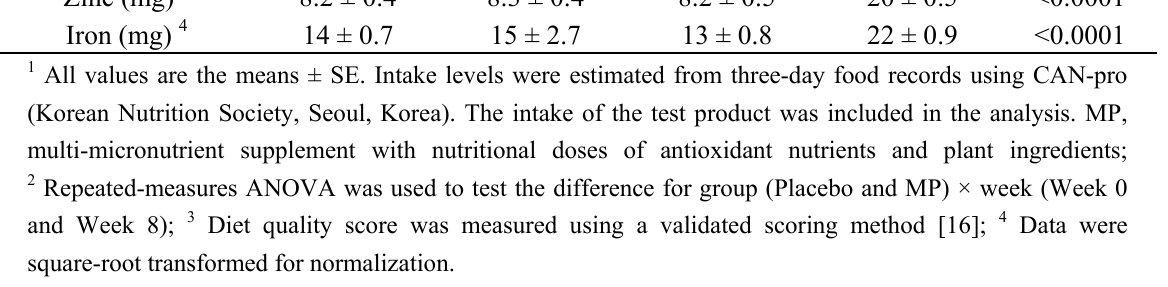
Figure 2. Relationship between the serum folate level and oxidative stress markers in all individuals at the end of the study, including comet tail intensity ( A ), comet tail moment ( B ), and plasma ox-LDL ( C ). The Pearson correlation coefficient ( r -value) and p -value are shown adjacent to the